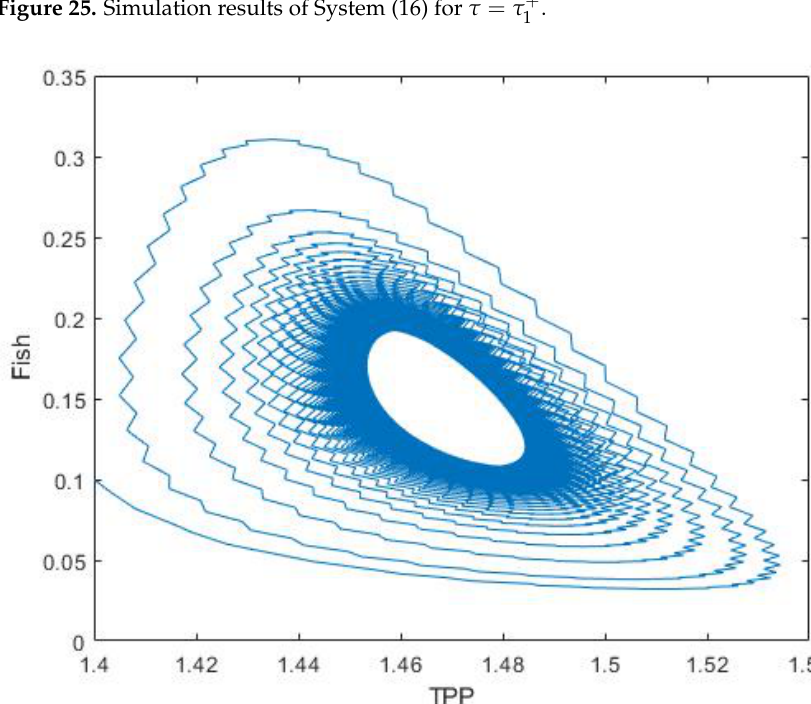
Figure 25. Simulation results of System (16) for τ = τ +